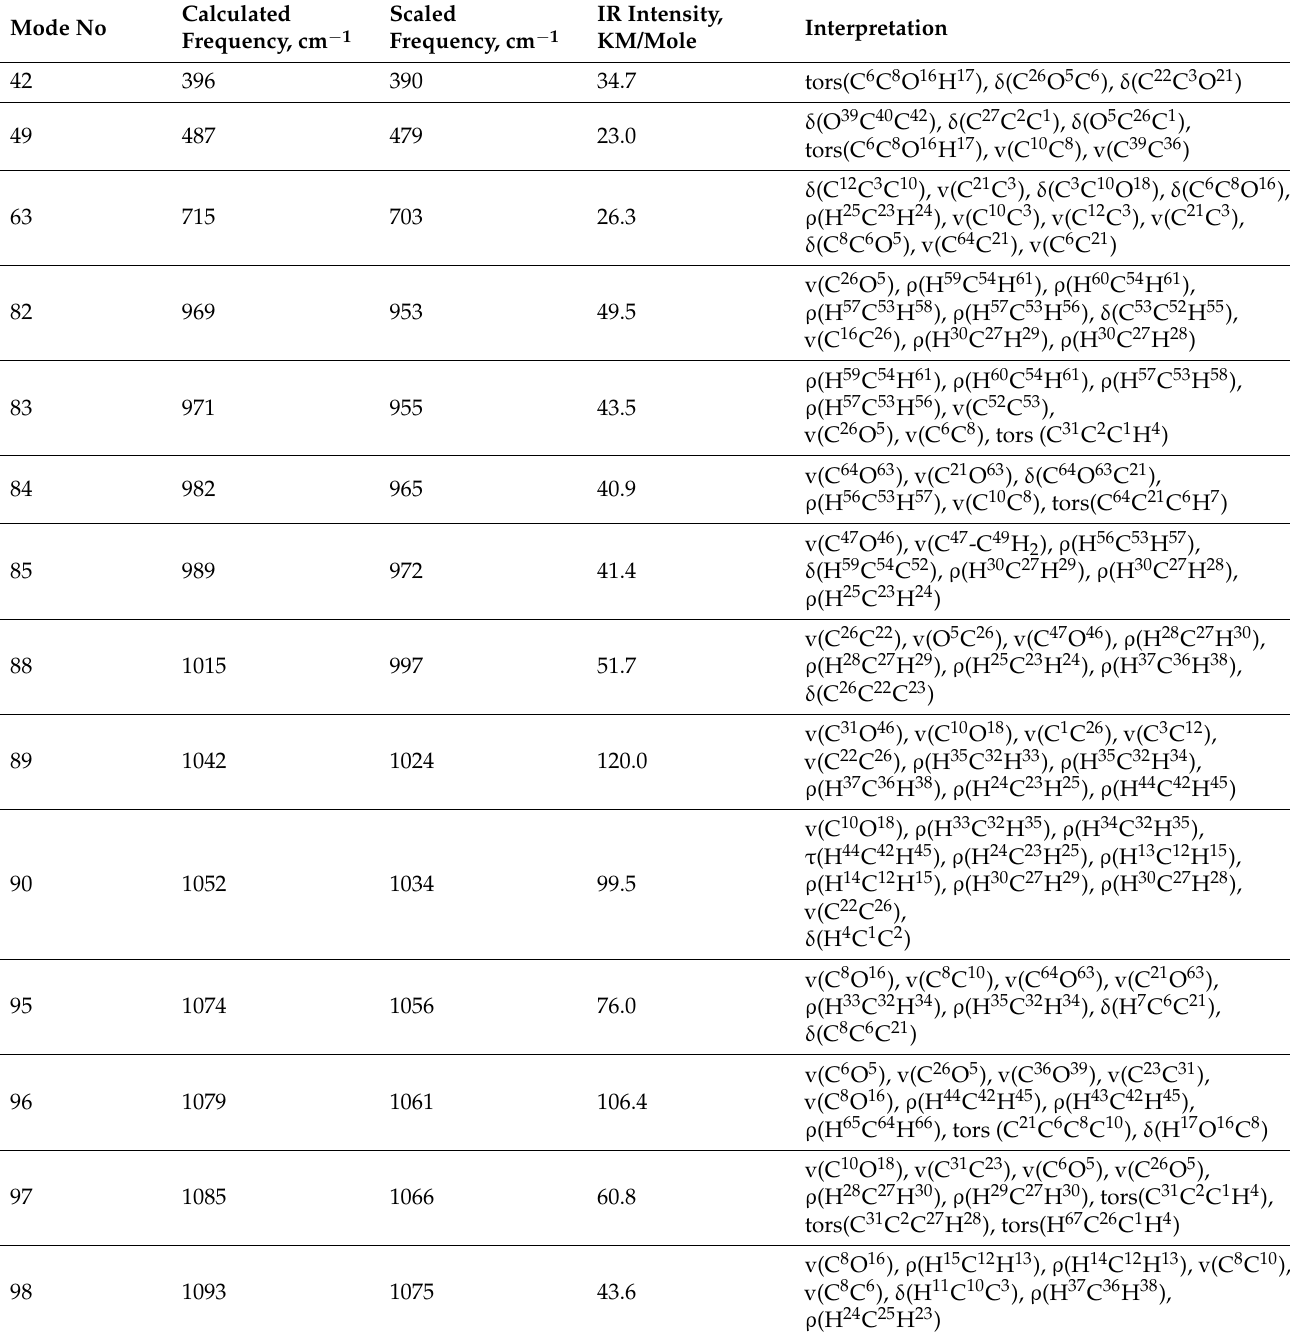
Table 2. Assignment of selected vibrational modes of the T-2 toxin molecule for calculated IR absorbance spectra. In the table, the following notations have been used: v—stretching vibra- tions, δ —bending vibrations, w—wagging, tors—torsional, τ —twisting, ρ —rocking modes, asym— asymmetric, sym—symmetric vibrations. In the case of water-like >CH 2 structures, v sym and v asym correspond to symmetric and asymmetric water-like stretching vibrations, with corresponding atoms in parentheses. The upper index denotes the atom number and lower index denotes the number of elements attached to the previous